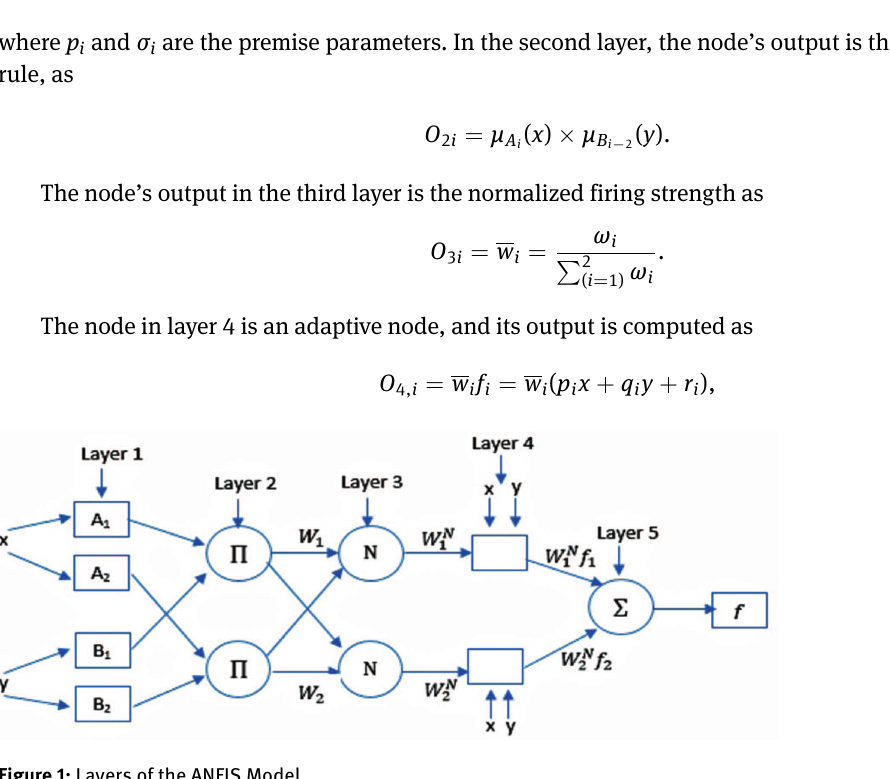
Figure 1: Layers of the ANFIS